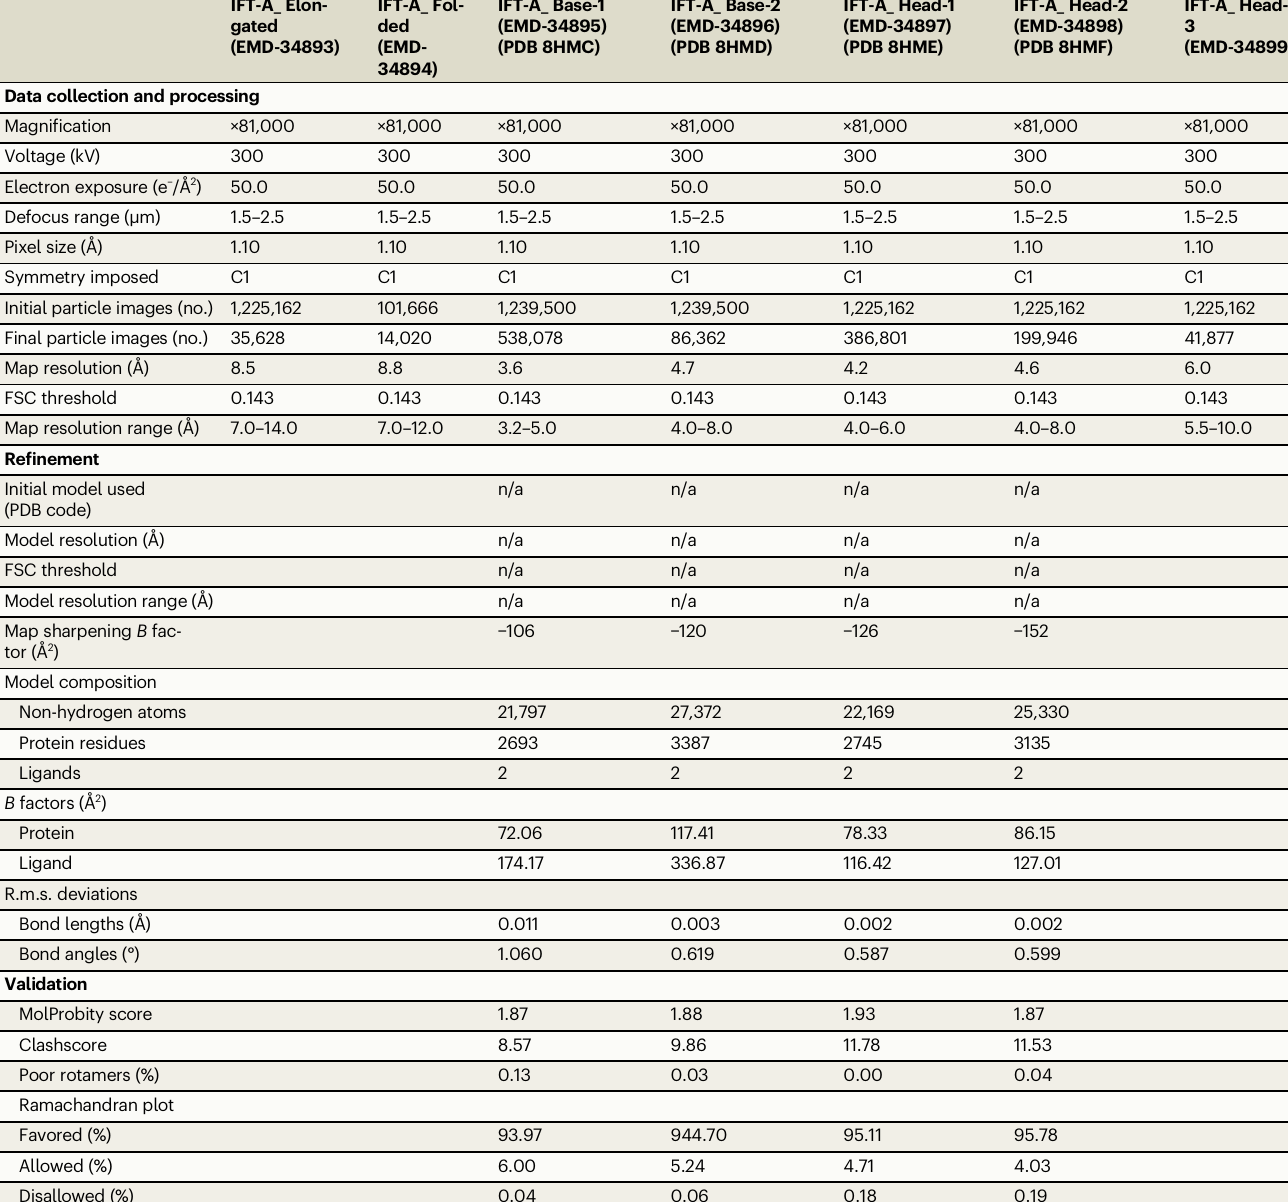
Table 1 | Cryo-EM data collection, re fi nement and validation